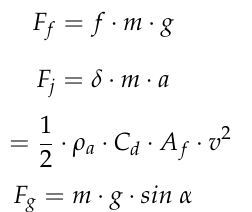
Table 1. Notation to calculate resistance.